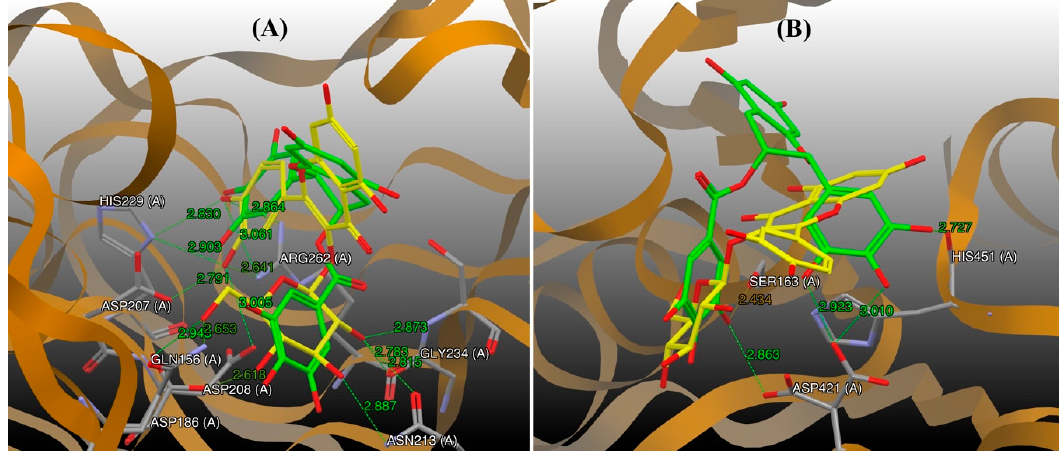
Figure 7. Molecular docking simulation in the active site of (A ) glycoside hydrolase and ( B ) tannase with the superimposed isoquercitrin (yellow) or EGCG (green). The colors of atoms represent their interaction with ligands as follows: gray, carbon; red, oxygen; and blue, nitrogen. Hydrogen atoms of protein residues and ligands are omitted for improving a graphical comprehension. The green dotted lines represent the hydrogen bonding. Other protein residues are depicted in ribbon, while catalytic residues are illustrated as capped sticks.